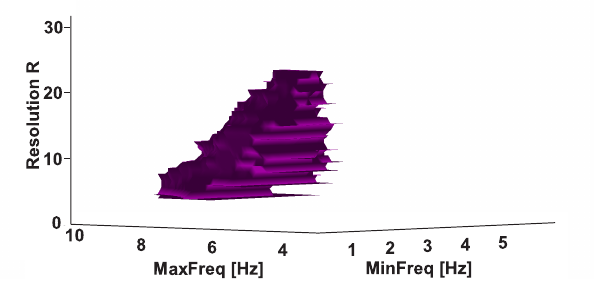
Figure 18. The isosurface p ≤ α B . Left-hand-tremor PD patients; extensor muscle; frequencies from 1 to 10 Hz. The abscissa axis indicates the lower bound of the frequency range, the ordinate axis indicates the upper bound of the frequency range, and the applicate axis indicates the R resolution.